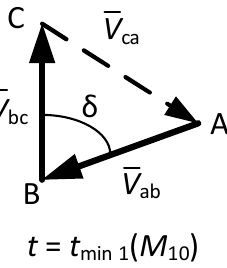
Figure 4. Phasor diagram of the reconstructed phase-to-phase voltages corresponding to the DC voltage profile shown in Figure 3, drawn at t = t min 1 (in measurement M 10 ).